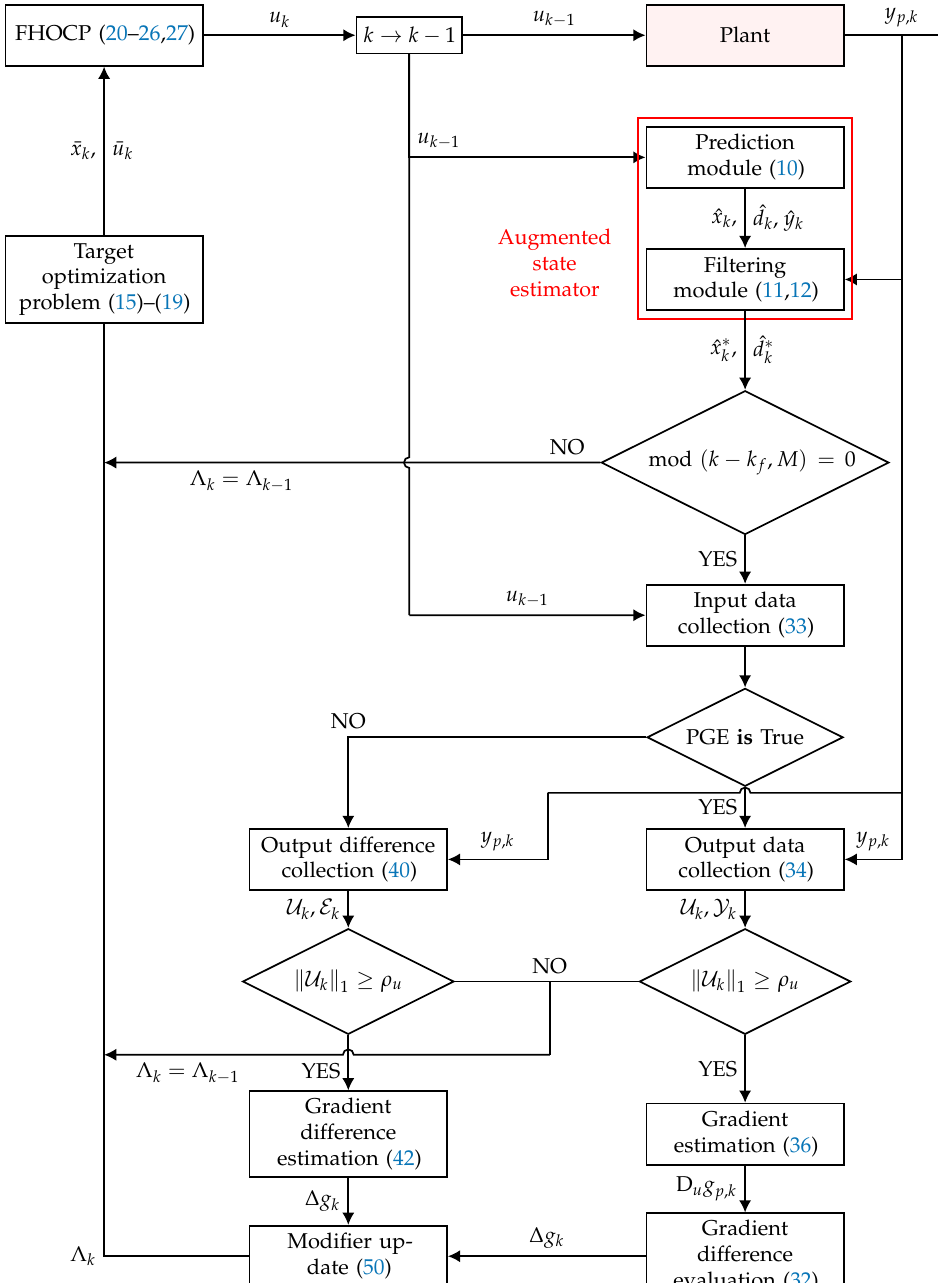
Figure 2. Block diagram for the eMPC algorithm described in Sections 2, 3.2.2, and 3.3.2 using the linear regression solution, for k > k f . The acronym PGE stands for Plant Gradient